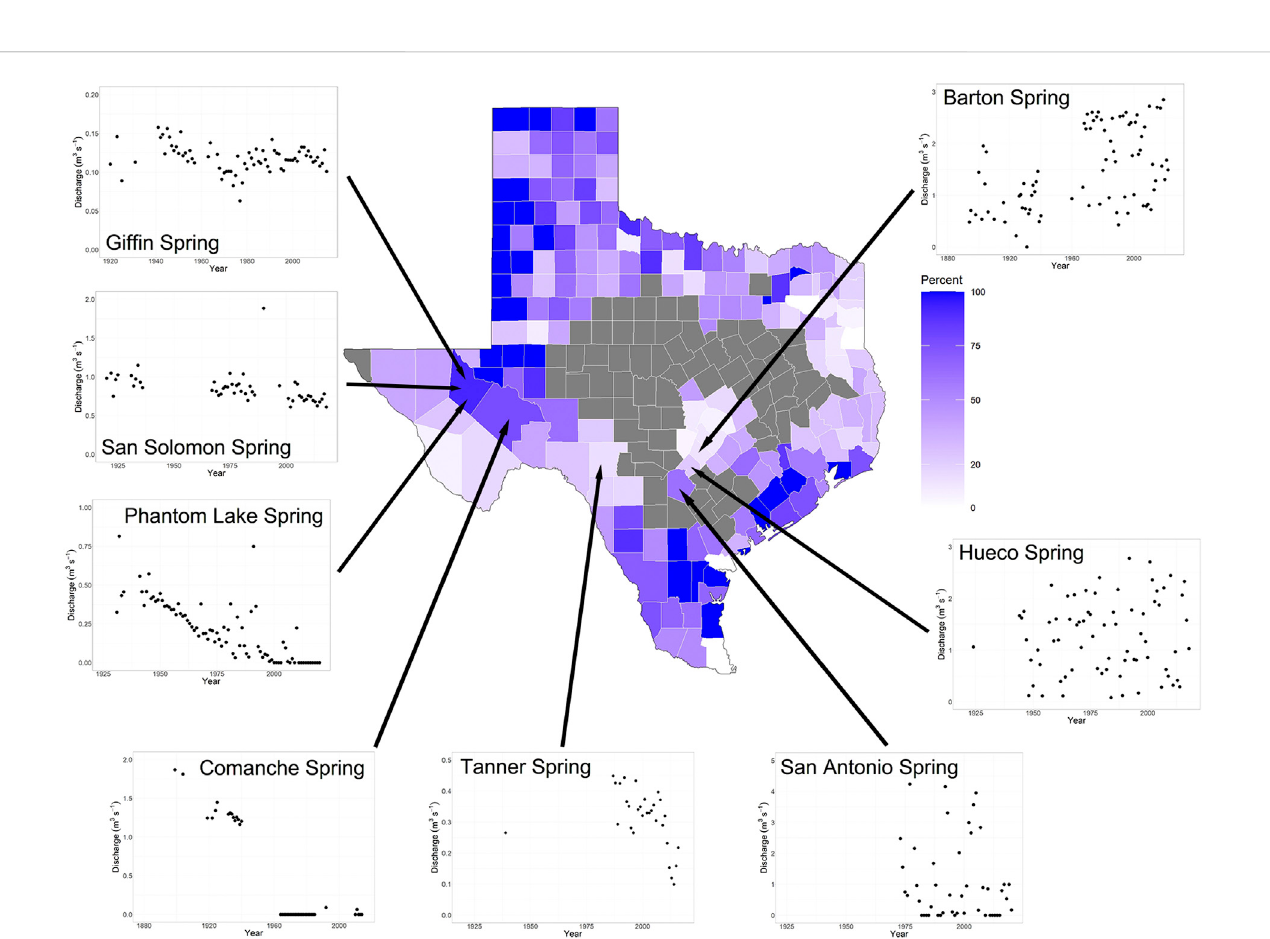
FIGURE 4 Trends in spring dischargefor Texas.The map depicts trends insprings in Texas countiesdescribed by Brune (1980).He evaluated springs inroughlyhalf ofthecounties inTexas and described thestatus ofthese springs inthe1970s.The counties that hedescribed are colorcoded for theproportion ofsprings in thecountythathedescribedasdrying,rangingfromwhite(nospringsinthecountydrying)todarkpurple(allspringsinthecountydrying).Greycountieswere not described in Brune (1980). The graphs surrounding the map represent USGS NWIS time series for springs in a subset of the counties described by Brune